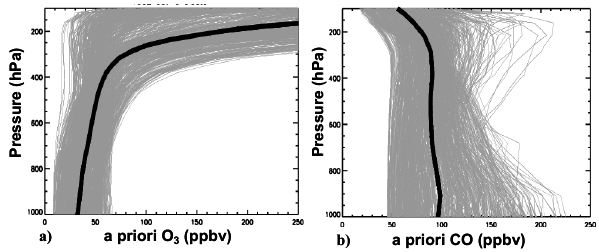
Fig. 1. The universal (bold black line) a priori profiles for (a) O 3 and (b) CO. The climatological a priori profiles between 60 ◦ N and 60 ◦ S from which the universal a prior profiles were generated are shown and grey and vary monthly and geographically in 10 ◦ × 60 ◦ latitude/longitude